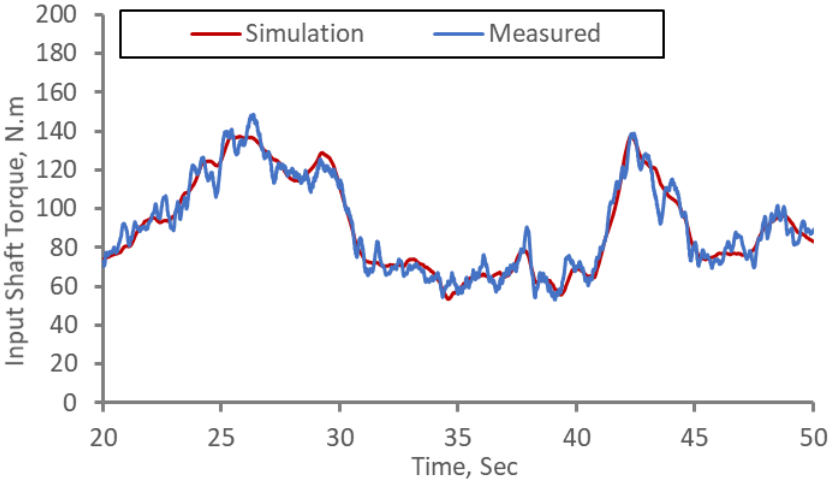
Figure 7. Comparison of simulation and measured input shaft torque.